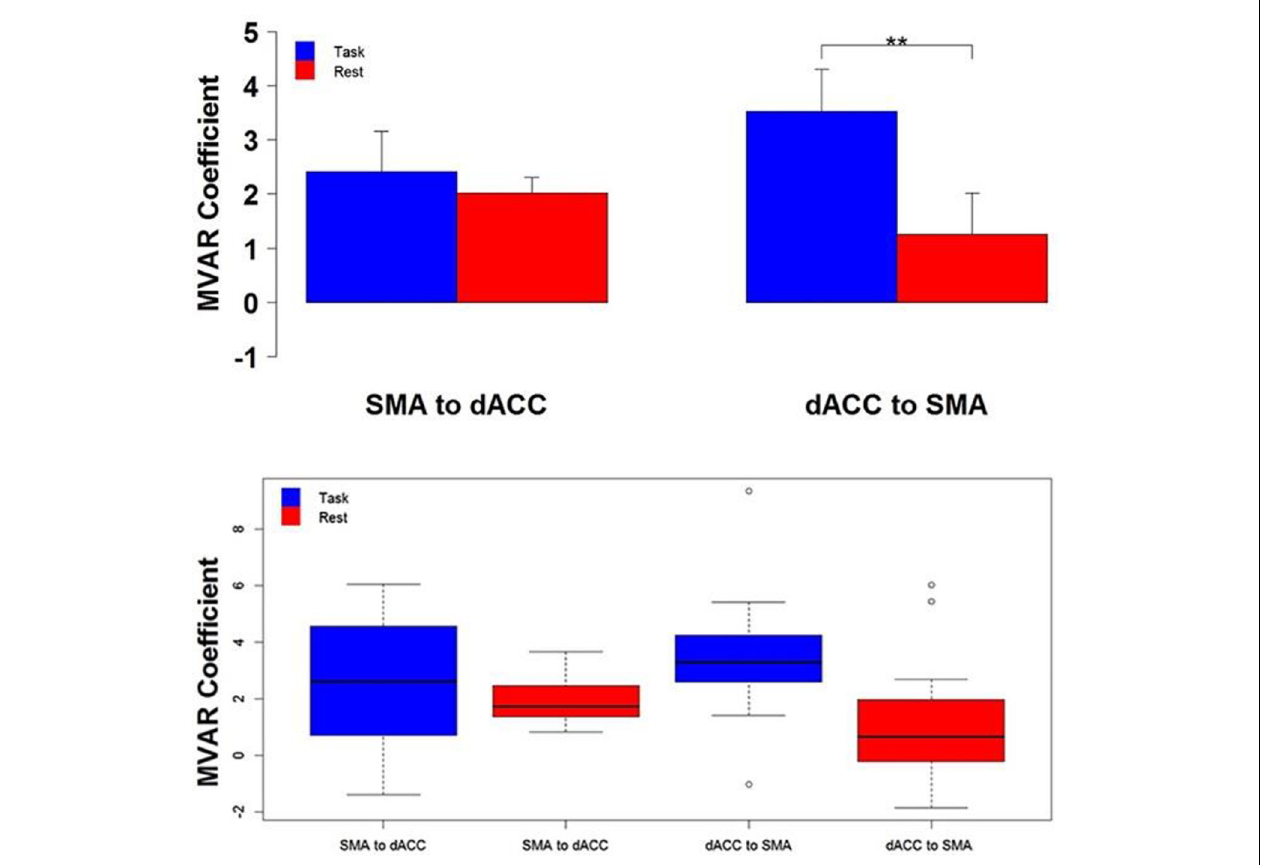
FIGURE 4 | Top The group mean and standard error of influence in both directions between the 2 ROIs (SMA to dACC, dACC to SMA) for Task (blue) and Rest (red) conditions. Post hoc paired t -tests revealed that the influence from dACC to SMA was significantly greater for Task than Rest, but that the influence from SMA to dACC did not significantly differ (** p < 0.01). Bottom The distribution across subjects for both directions between the 2 ROIs (SMA to dACC, dACC to SMA) and for Task (blue) and Rest (red) conditions, as box plots. Note that the distribution for the influence from dACC to SMA during the Task is both more compact than and elevated above the distribution during Rest (Figure modified from Asemi et al.,